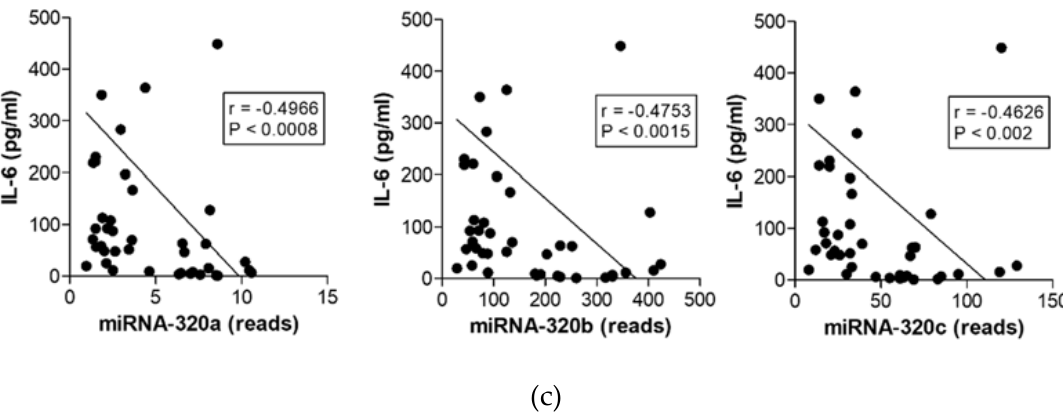
Figure 4. Correlations between expression of the miR ‐ 320 family members with markers of inflammation and coagulation. Correlations between miR ‐ 320a, miR ‐ 320b, and miR ‐ 320c and ( a ) CRP, ( b ) D ‐ dimer and ( c ) IL ‐ 6 concentration analyzed in the peripheral blood of patients with moderate and severe respiratory failure induced by COVID ‐ 19 infection and healthy controls.